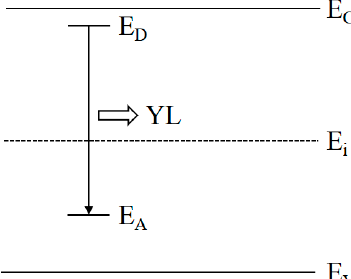
Figure 7. Schematic diagram of the proposed transition model about the YL in u-GaN samples.